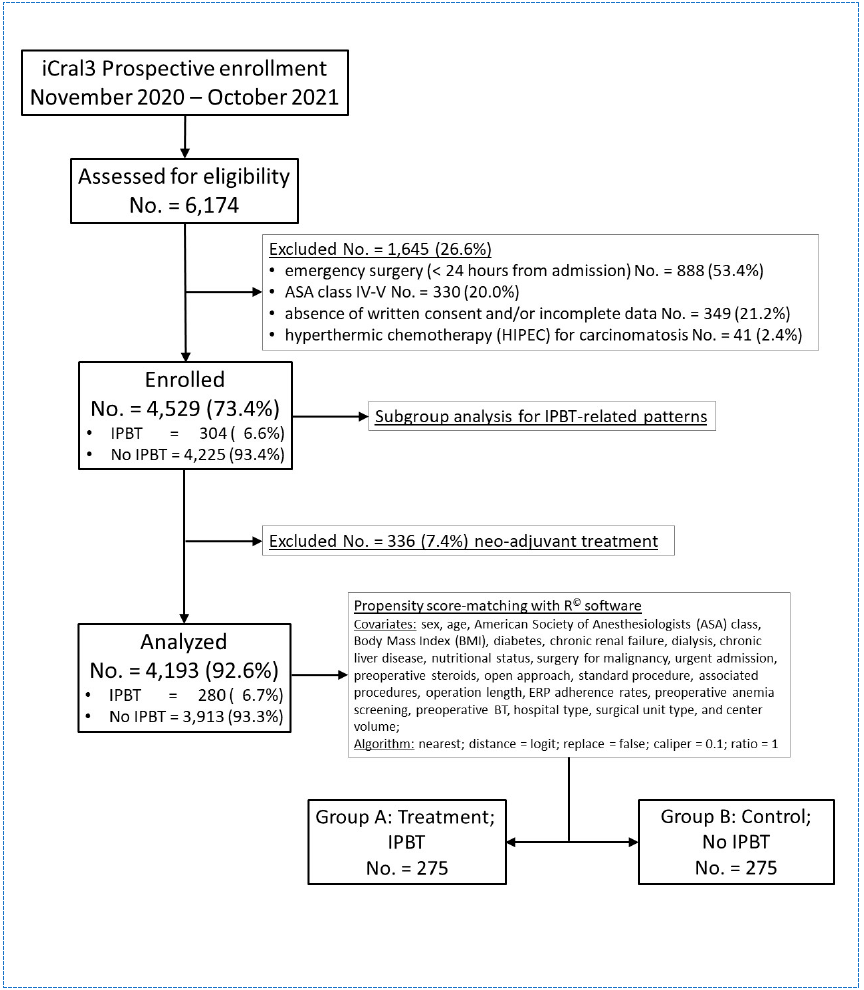
Figure 1. Study flowchart according to the Strengthening the Reporting of Observational Studies in Epidemiology (STROBE) statement guidelines [17] and to the Reporting and Guidelines in Propen- sity Score Analysis [18]: iCral: Italian ColoRectal Anastomotic Leakage study group; ASA: American Society of Anesthesiologists; IPBT: intra- and/or postoperative blood transfusion(s); and ERP: en- hanced recovery